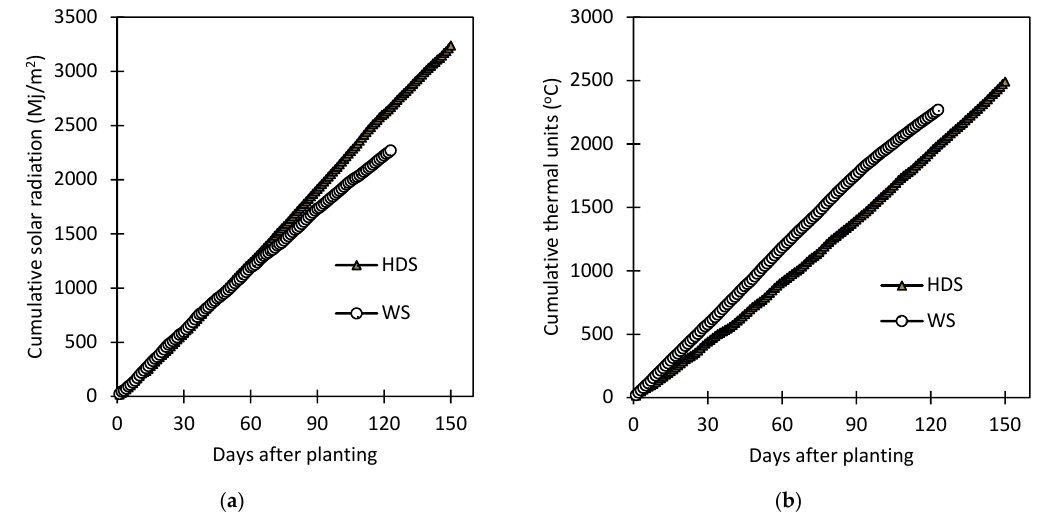
Figure 4. Cumulative solar radiation ( a ) and cumulative thermal units ( b ) in the hot and dry (HD) and wet (W) growing seasons as a function of days after planting.